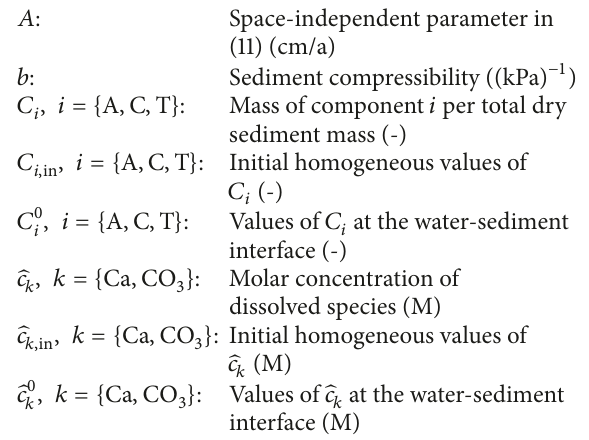
Figure 9: (a) Dimensionless time series illustrating the deterministic evolution of the calcite composition 𝐶 c and the terrigenous composition 𝐶 T at the bottom of the sediment when the system is subjected to weak periodic driving of period 10 case 2. The transients are omitted. (b–d) Calcite composition 𝐶 c when the system is also subjected to colored noise fluctuations for a noise intensity of 𝜎 = 0.0001 (b), 𝜎 = 0.001 (c), and 𝜎 = 0.005 (d). (e) Power spectrum of (c). (f) 0-C residence time distribution for 𝜎 = 0.00125. (g) Signal-to-noise ratio as a function of the noise